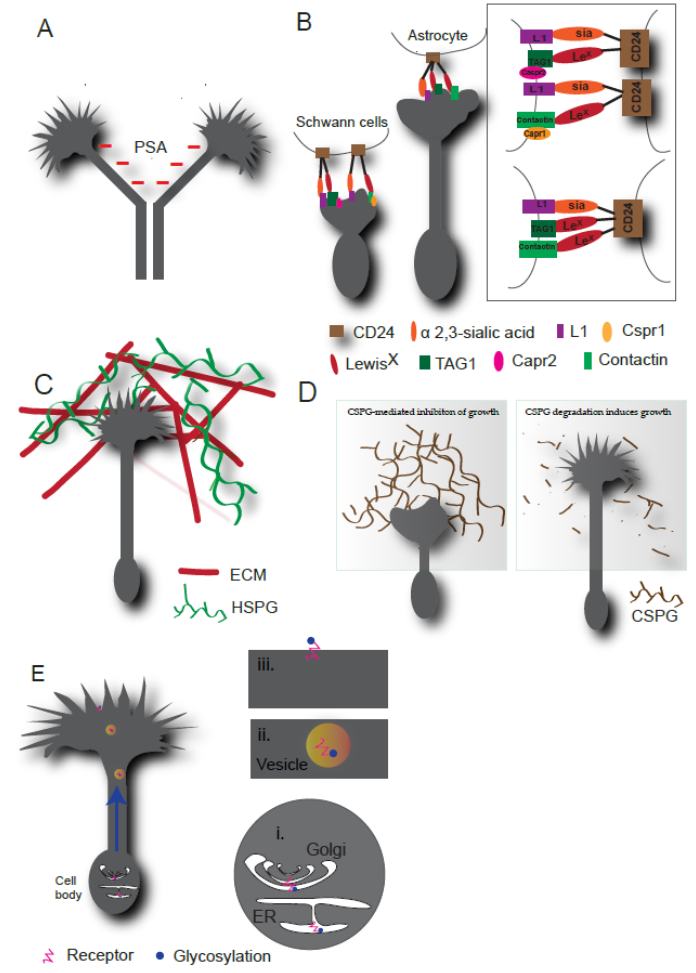
Figure 2. Functions of glycosylation in axon guidance. ( A ) PSA (shown in red) acts as negative regulator of axon fasciculation. ( B ) L1 on neurons binds to α 2,3-sialic acid carried by CD24. Neuronal contactin and TAG1 bind to Lewis x carried by CD24. This CD24, L1, TAG1 and contactin complex causes signal transduction to induce neurite outgrowth in cerebellar neurons (right). In DRG neurons, TAG1 of the TAG1-CD24 complex interacts with Cspr2 and contactin of the contacin-CD24 complex interacts with Cspr1 (left). These two independent complexes cause signal transduction to inhibit neurite outgrowth (box in the right corner shows all the complexes, top: outgrowth inhibiting complex, bottom: outgrowth promoting complex. ( C ) HSPGs are major components of ECM and can modulate neuronal microenvironment by organizing ECM and guidance molecules. ( D ) CSPGs form an inhibitory zone around neurons (left), enzymatic removal CSPGs causes the reversal of inhibition and promotes the growth. ( E ) Role of glycosylation in receptor trafficking and surface representation. On right, (i) ER-Golgi transition (ii) vesicle containing glycosylated receptor and (iii) surface representation of glycosylated receptor are shown. Multiple proteins bind and form a complex with PSA to regulate their functions. Cell surface-exposed PSA interacts with morphogenic factors such as BDNF, NGF, and NT3, and activate their receptors. PSA-bound BDNF leads to activation of BDNF receptors TrkB and p75NTR, resulting in increased survival and growth of neuroblastoma cells [37]. Apart from the NCAM-mediated adhesion by PSA discussed above, PSA has multiple binding partners in the nervous system that regulate processes from neurogenesis to synapse formation in the developing nervous system [24]. However, detailed molecular mechanisms of how PSA modulates these functions need to be investigated to understand higher-order functions of PSA in the nervous